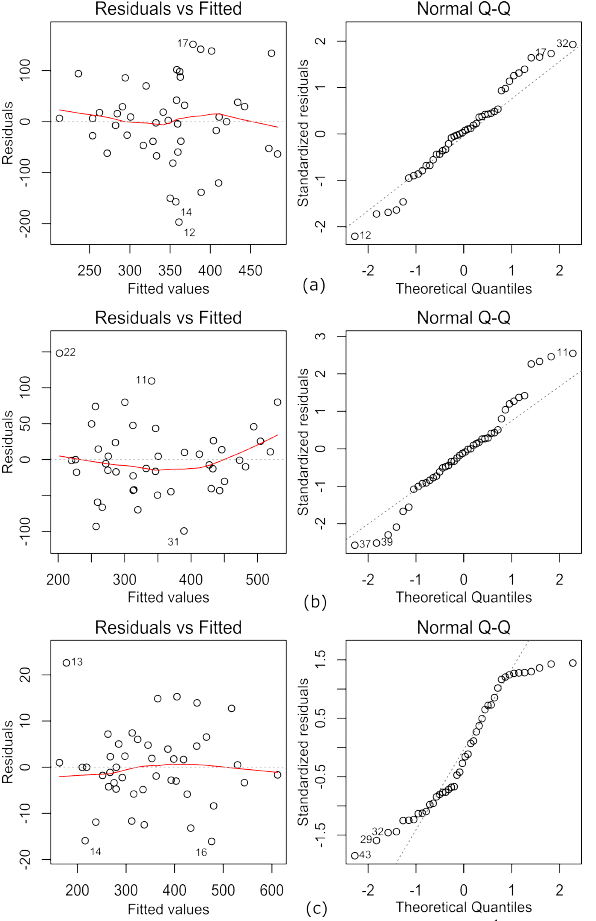
Figure 4. Statistical visualization of (a) linear, (b) 2 nd degree polynomial and (c) 3 rd degree polynomial type of three multiple regression analysis